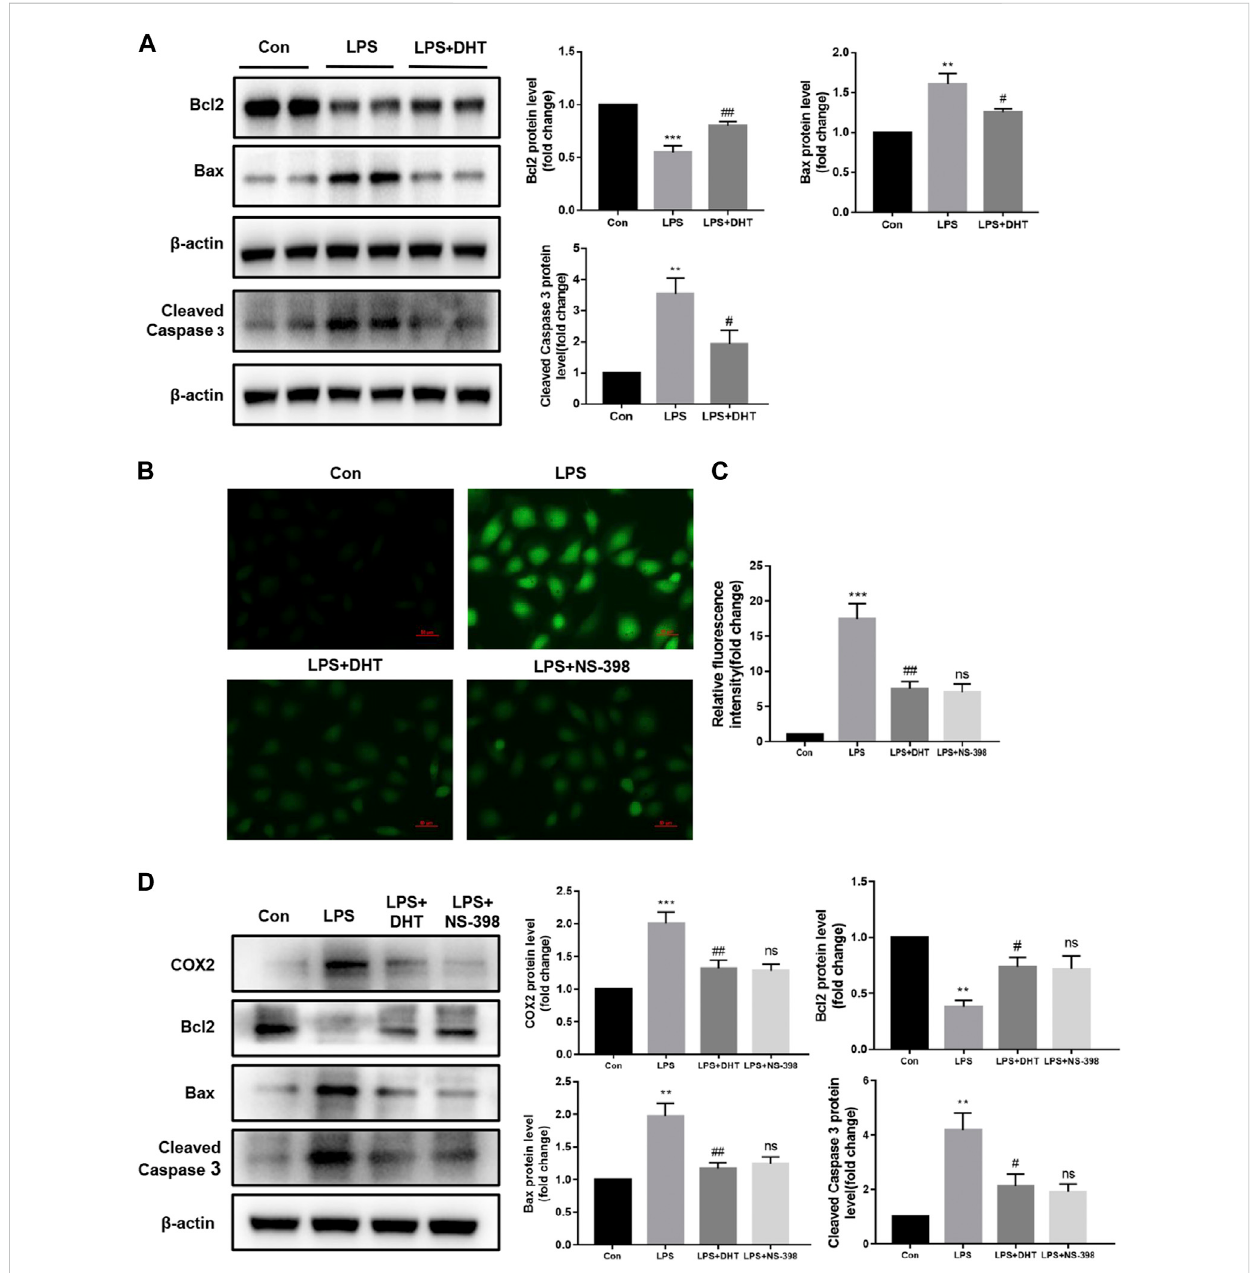
FIGURE 8 DHT alleviated LPS-induced apoptosis in HK-2 cells. (A) Representative Western blot and quantitative data showing the effect of DHT on the expression levels of Bcl2, Bax, and cleaved caspase 3 in LPS-induced HK-2 cells (n = 3). ** p < 0.01, *** p < 0.001 vs. Con, # p < 0.05, ## p < 0.01 vs. LPS. (B) Representative image of ROS measured by fl uorescence microscopy in each group. Scale bars: 50 μ m. (C) Quantitative data of ROS fl uorescence intensity in HK-2 cells (n = 3). *** p < 0.001 vs. Con, ## p < 0.01 vs. LPS, ns vs. LPS + DHT. (D) Representative Western blot and quantitative data showing the level of COX2 and apoptosis-related proteins in Con, LPS, LPS + DHT, and LPS + NS-398 (n = 3). ** p < 0.01, *** p < 0.001 vs. Con, # p < 0.05, ## p < 0.01 vs. LPS, ns vs. LPS +